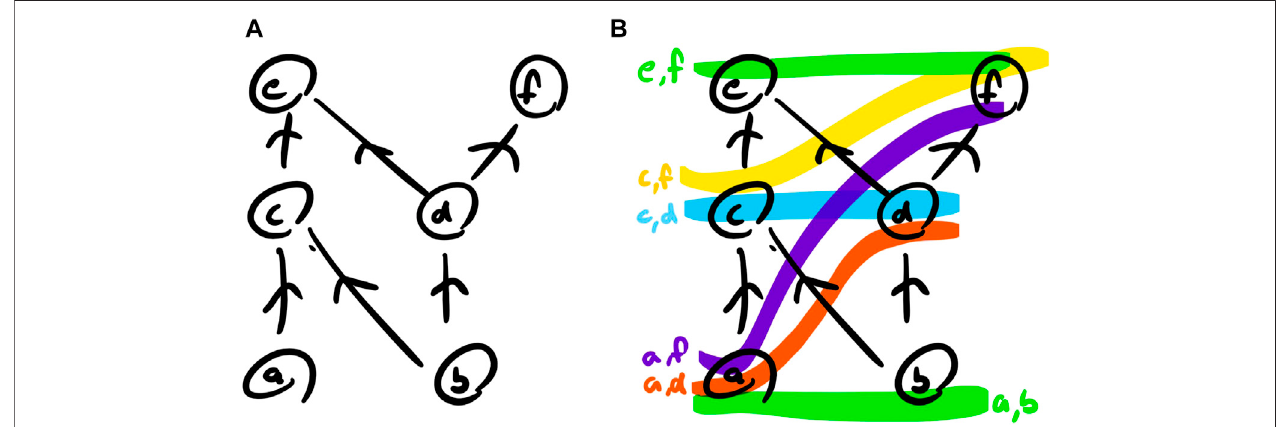
FIGURE 1 | (A) : the Hasse diagram for a causal order on six events { a , b , c , d , e , f } . (B) : the maximal slices for the causal order highlighted (all other slices can be obtained as subsets of the maximal